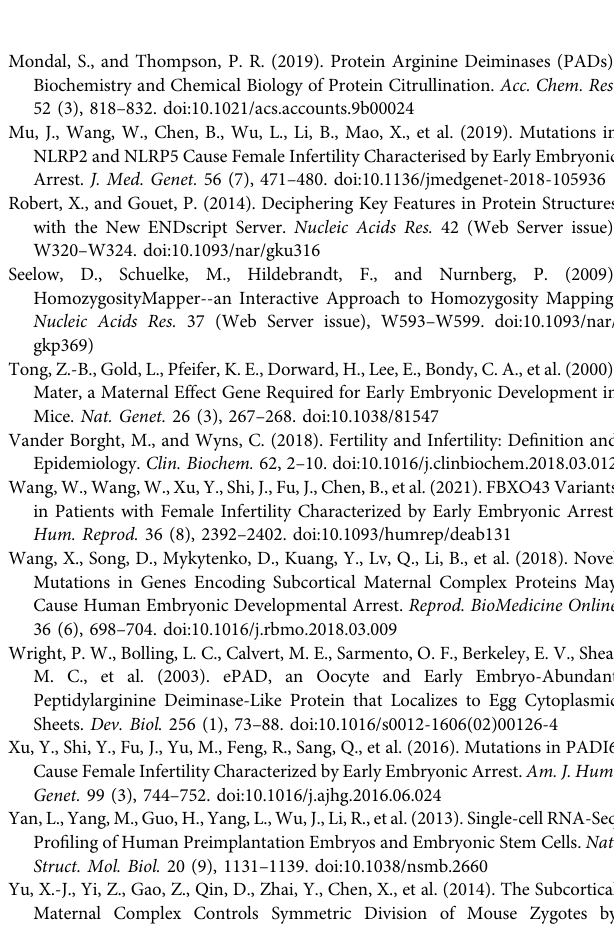
Supplementary Figure S1 | Expression pattern of four candidate genes identi fi ed from family 1. (A) Expression dynamics of four candidate genes according to our in- house RNA-Seq data. GV: germinal vesicle oocyte; MI: metaphase I oocyte; MII: metaphase IIoocyte. (B) Expressiondynamicsoffourcandidategenesaccordingto single-cell RNA-Seq data published by Yan et al (Yan et al., 2013). Supplementary Figure S2 | Quantitative RT-PCR analysis of PADI6 mRNA expression in HEK-293T cells transfected with wild-type or mutant plasmids. **, p < 0.01; ***, p <